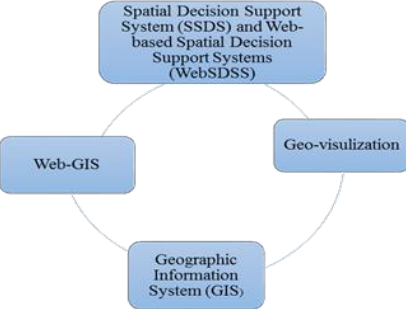
Figure 2. Data management and visualisation techniques and tools